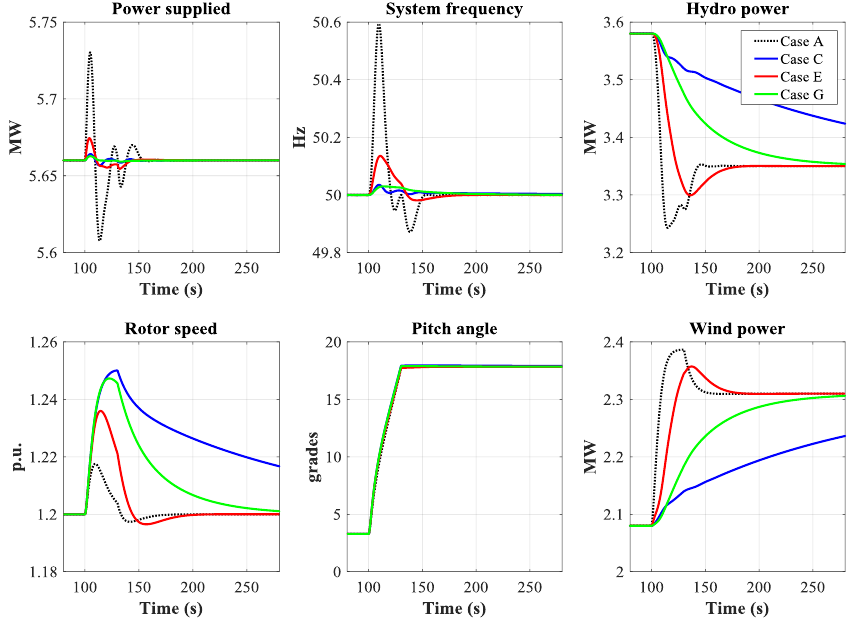
Figure 12. Comparison of the dynamic responses of the system between the base case and the cases in which the VSWT contributes to the regulation assuming different control strategies during a wind speed ramp.